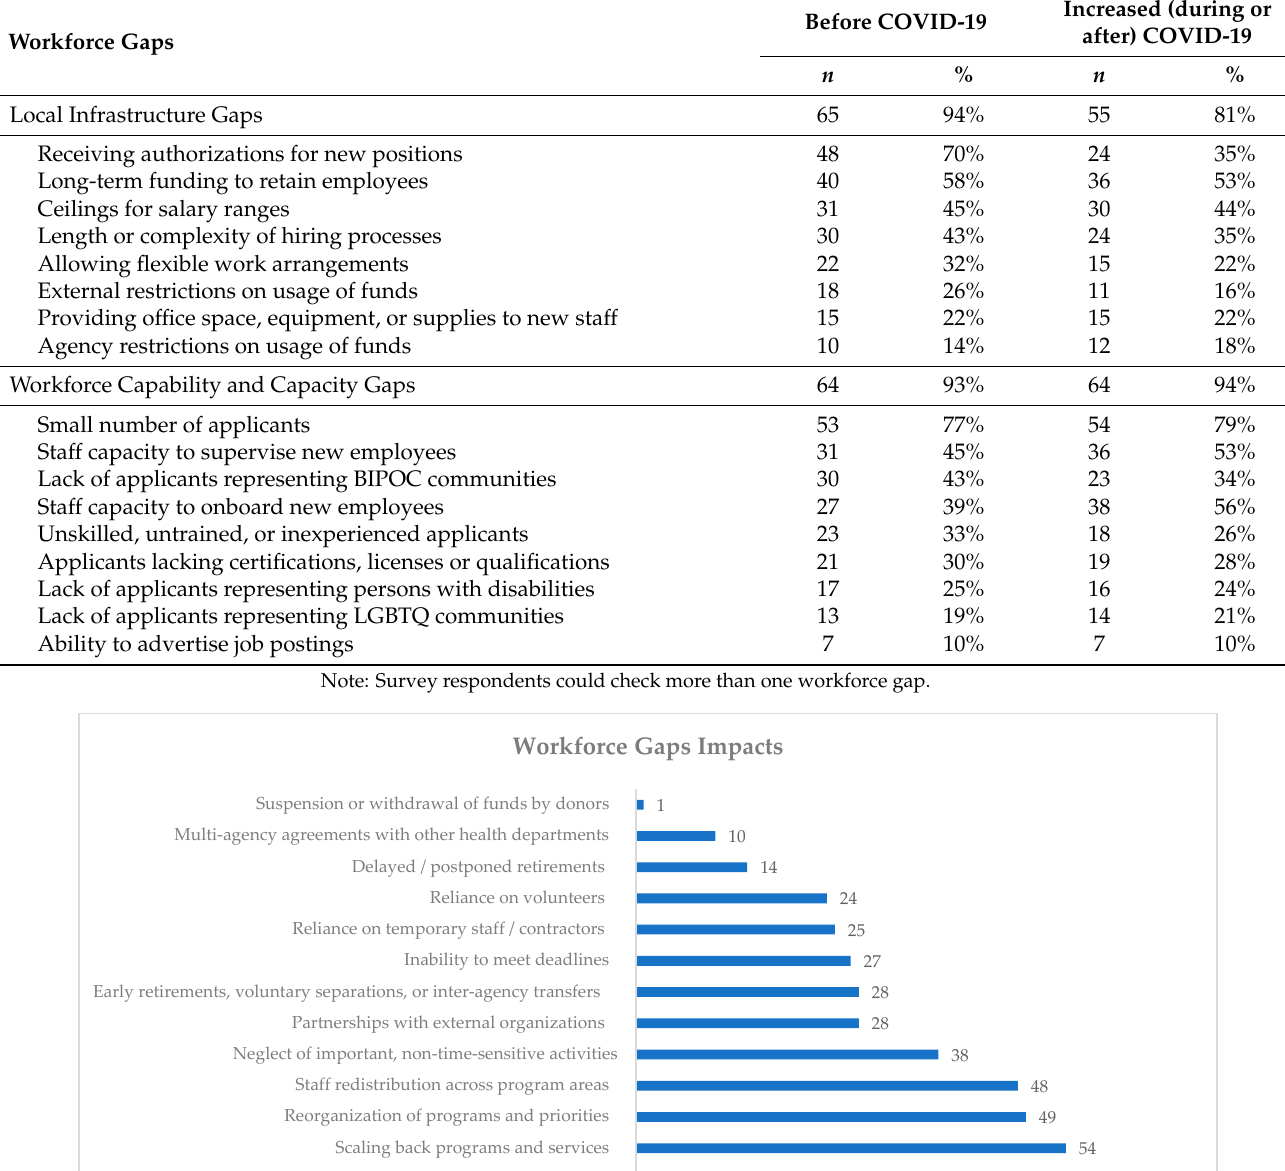
Table 2. Workforce gaps survey respondents’ agencies experienced before and increased during or after COVID-19 sorted by focus group themes. ( n = 69 Before COVID-19; n = 68 Increased during or after COVID-19).